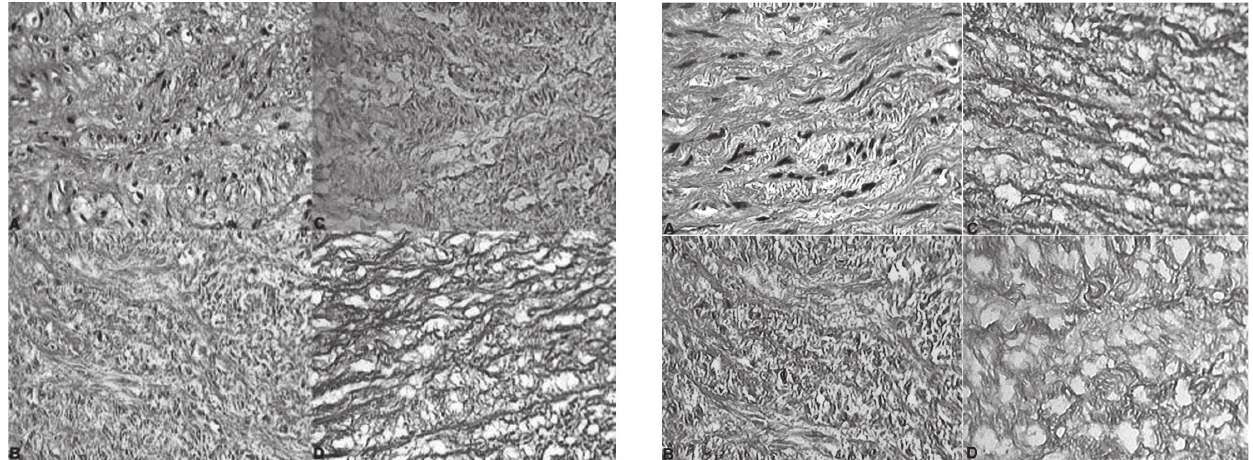
Fig. 1 - À esquerda: análise qualitativa da matriz extracelular de condutos pulmonares submetidos a processo de descelularização. A – Controle Pré- Descelularização. B – DOA 1%; C – SDS 0,1% e D – SDS 0,3%. À direita: análise qualitativa da matriz extracelular de condutos pulmonares criopreservados e submetidas a processo de descelularização. A – Controle criopreservado. B – DOA 1%; C – SDS 0,1% e D – SDS